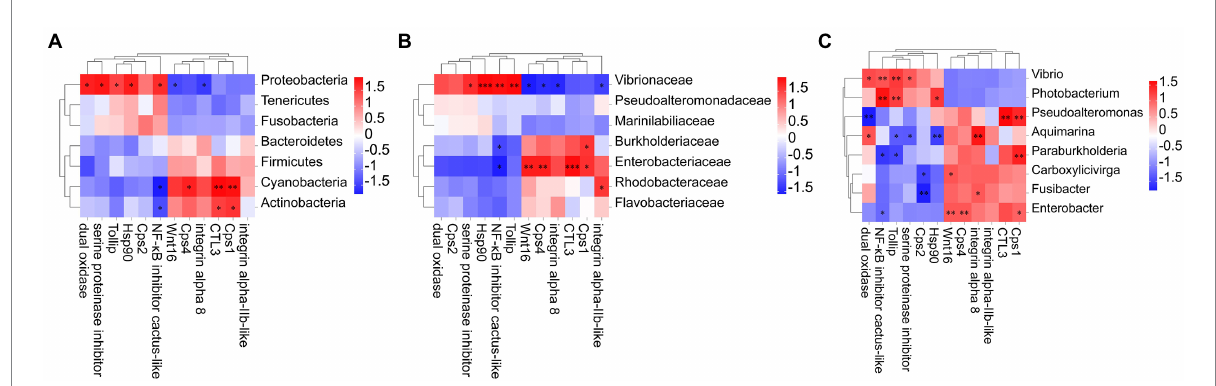
FIGURE 6 Heat map of the correlation between host intestinal bacteria under DIV1 infection at the phylum (A) , family (B) genus, and (C) classification levels and immune-related DEGs. Different colours indicate correlation coefficients. Red indicates positive correlations, and blue indicates negative correlations. * indicates significant differences (* p < 0.05; ** p < 0.01; *** p < 0.001). Cps1, Caspase 1; Ctl3, C-type lectin 3; Cps4, Caspase 4; Tollip, Toll interacting protein; Hsp90, heat shock protein 90; Cps2, Caspase